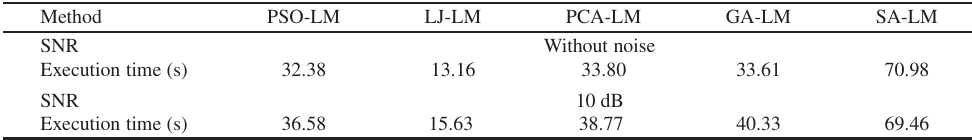
Table 3 Comparative performance of the hybrid techniques (computing time) in the benchmark damage identification